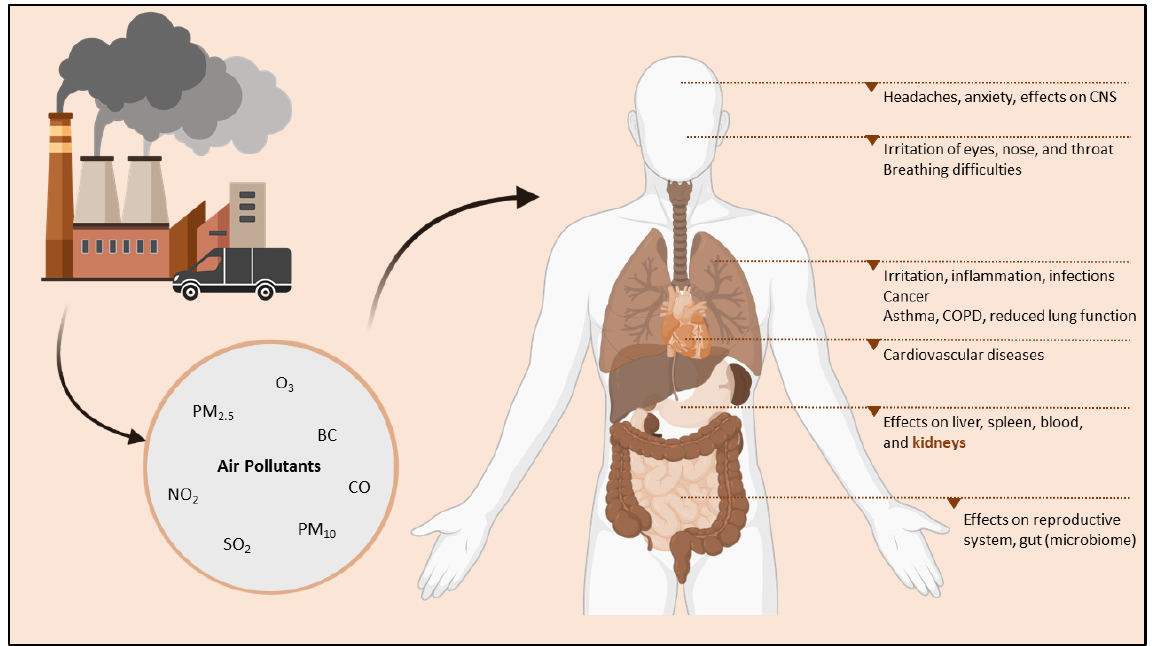
Figure 2. Air pollutants derived from the air pollution generated by, e.g., industry and vehicle emissions negatively influence organs beyond the lungs, possibly causing, e.g., cardiovascular diseases and exerting effects on the central nervous system, liver, kidneys, spleen, and blood. Image created with Biorender ® . Abbreviations: BC, black carbon; CNS, central nervous system; CO, carbon monoxide; COPD, chronic obstructive pulmonary disease; NO 2 , nitrogen dioxide; O 3 , ozone; PM 2.5 , fine particulate matter; PM 10 , coarse particulate matter; SO 2 , sulfur dioxide.